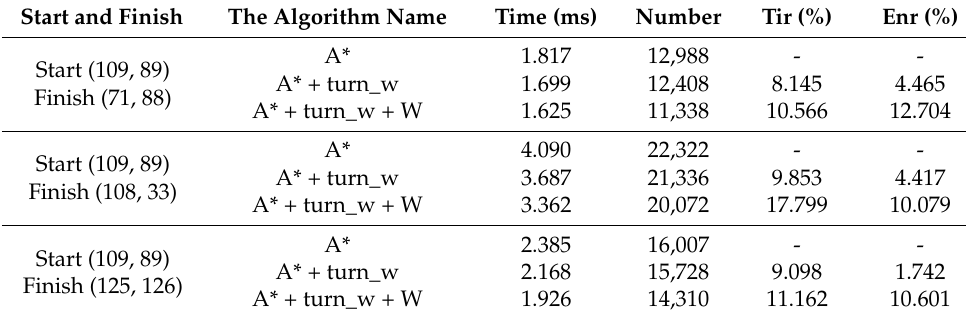
Figure 15. Example path planning diagram. ( a ) The first type of path planning, ( b ) The second type of path planning. The coordinate system position represents the starting position of the mobile robot, the red circle represents the target position, the green path is used to represent the result of the original A* algorithm, and the red path represents the result of the improved A* algorithm. Table 2. Performance comparison of three different path planning algorithms. Start and